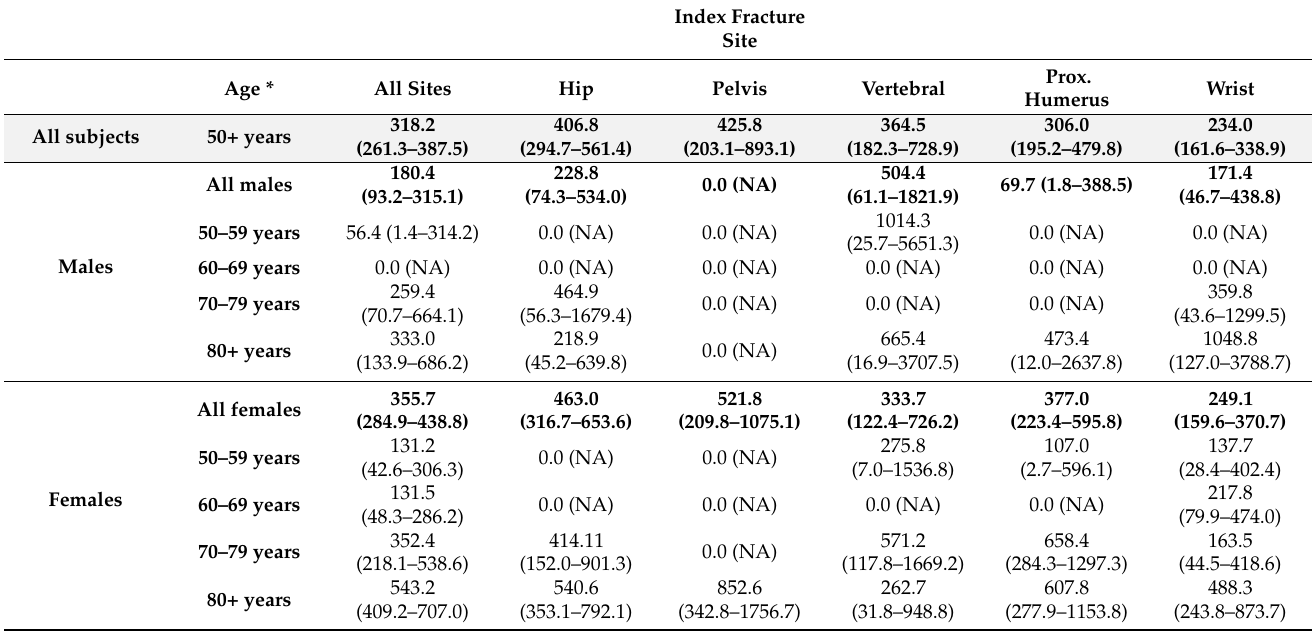
Table 2. Incidence rate of subsequent fractures (any site) among patients with an index fracture, by index fracture site, sex, and age group. The total population values for males and females are marked in bold. The shading indicates that they are total values of the population, to differentiate them from the rest that are separated by gender and age.